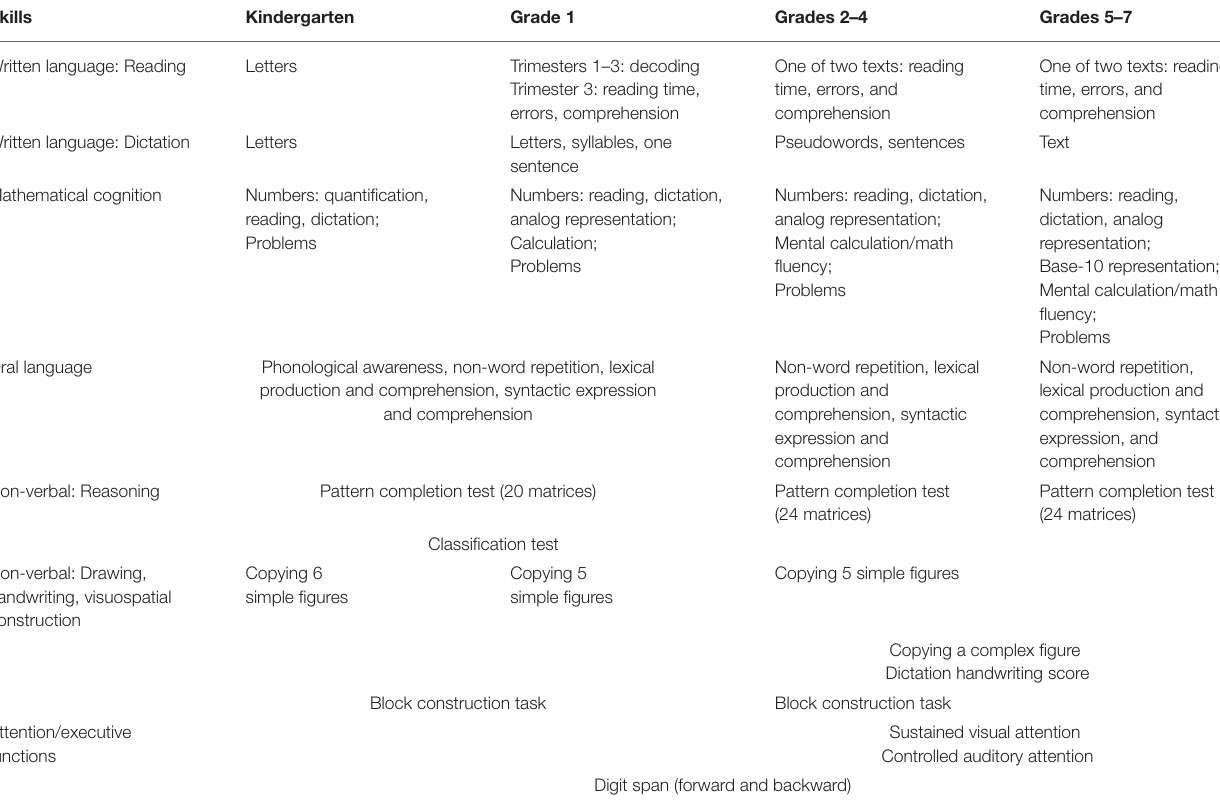
TABLE 1 | Overview of BMT- i tasks.